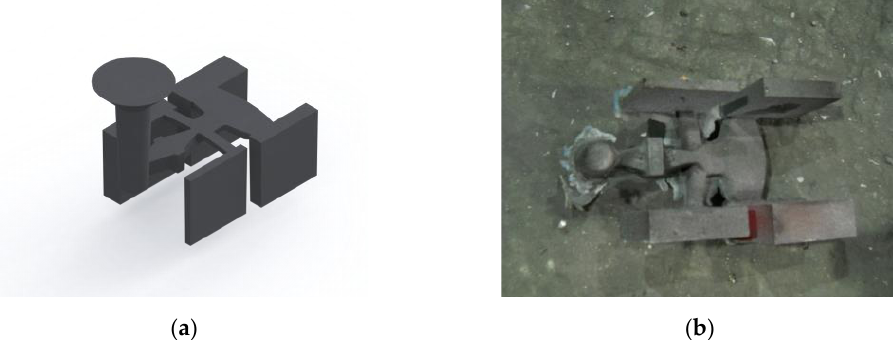
Figure 2. ( a ) Model of the research casting; ( b ) the appearance of the casting immediately after removing the mold. Table 3. Chemical composition of hypoeutectic chromium cast iron, wt%. Inoculant Addition C Si Mn